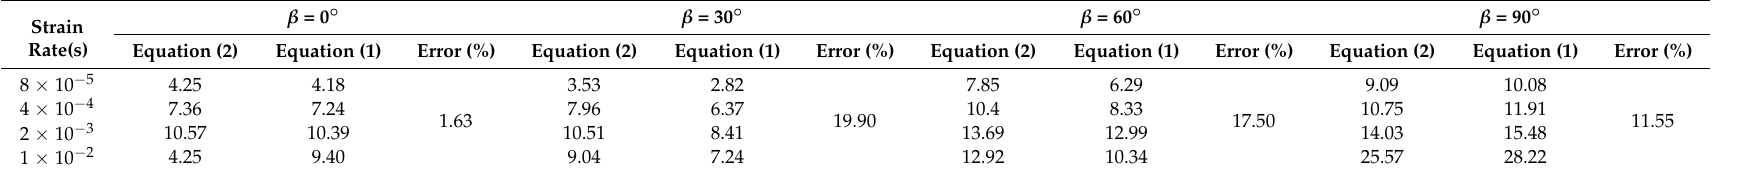
Table 2. Dynamic tensile strength of shale samples with different orientations using Equations (1) and